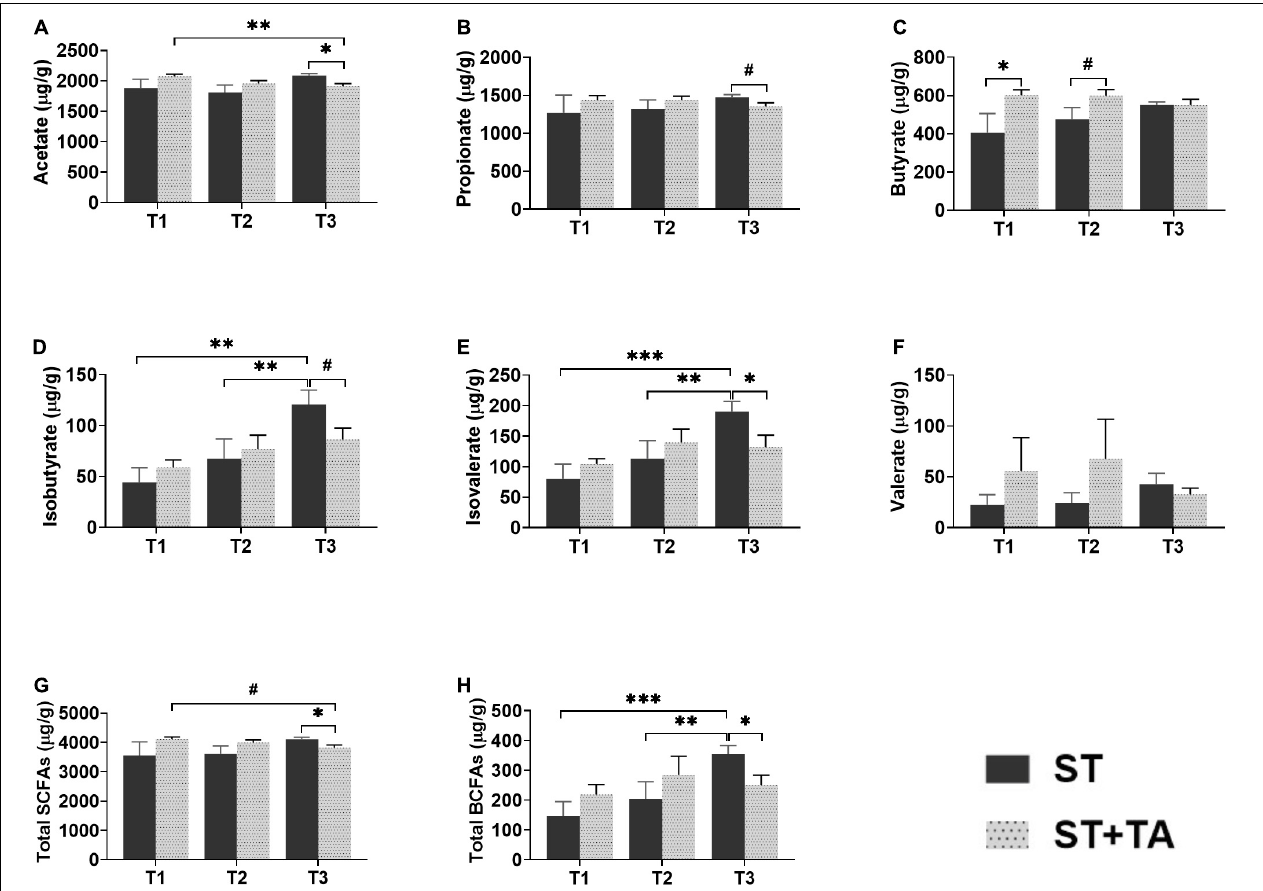
FIGURE 6 | Effect of TA on acetate (A) , propionate (B) , butyrate (C) , isobutyrate (D) , isovalerate (E) , valerate (F) , total SCFAs (G) , and total BCFAs (H) in dogs. Data are presented as mean ± SE ( n = 6 or 7). ∗ p < 0.05, ∗∗ p < 0.01, and ∗∗∗ p < 0.001 represent the difference calculated by Student’s t -test between the ST and ST + TA groups or the difference of each group at T1–T3 calculated by RM-ANOVA; # p < 0.10 represents the difference in tendency calculated by Student’s t -test between the ST and ST + TA groups or the difference in tendency of each group at T1–T3 calculated by RM-ANOVA. T1, day 7 before transportation; T2, day 8 after transportation; T3, day 14 after transportation. Total SCFAs (short-chain fatty acids) = acetate + propionate + butyrate; Total BCFAs (branched-chain fatty acids) = isobutyrate + isovalerate +